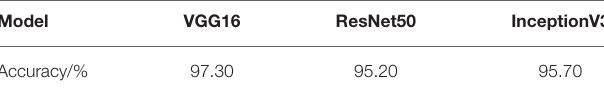
TABLE 2 | Accuracy of the classification model validation in the second stage. TABLE 4 | Comparison of the results in the semantic segmentation models.